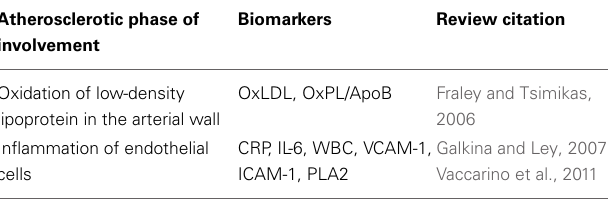
Table 1 | Sub-clinical CAD